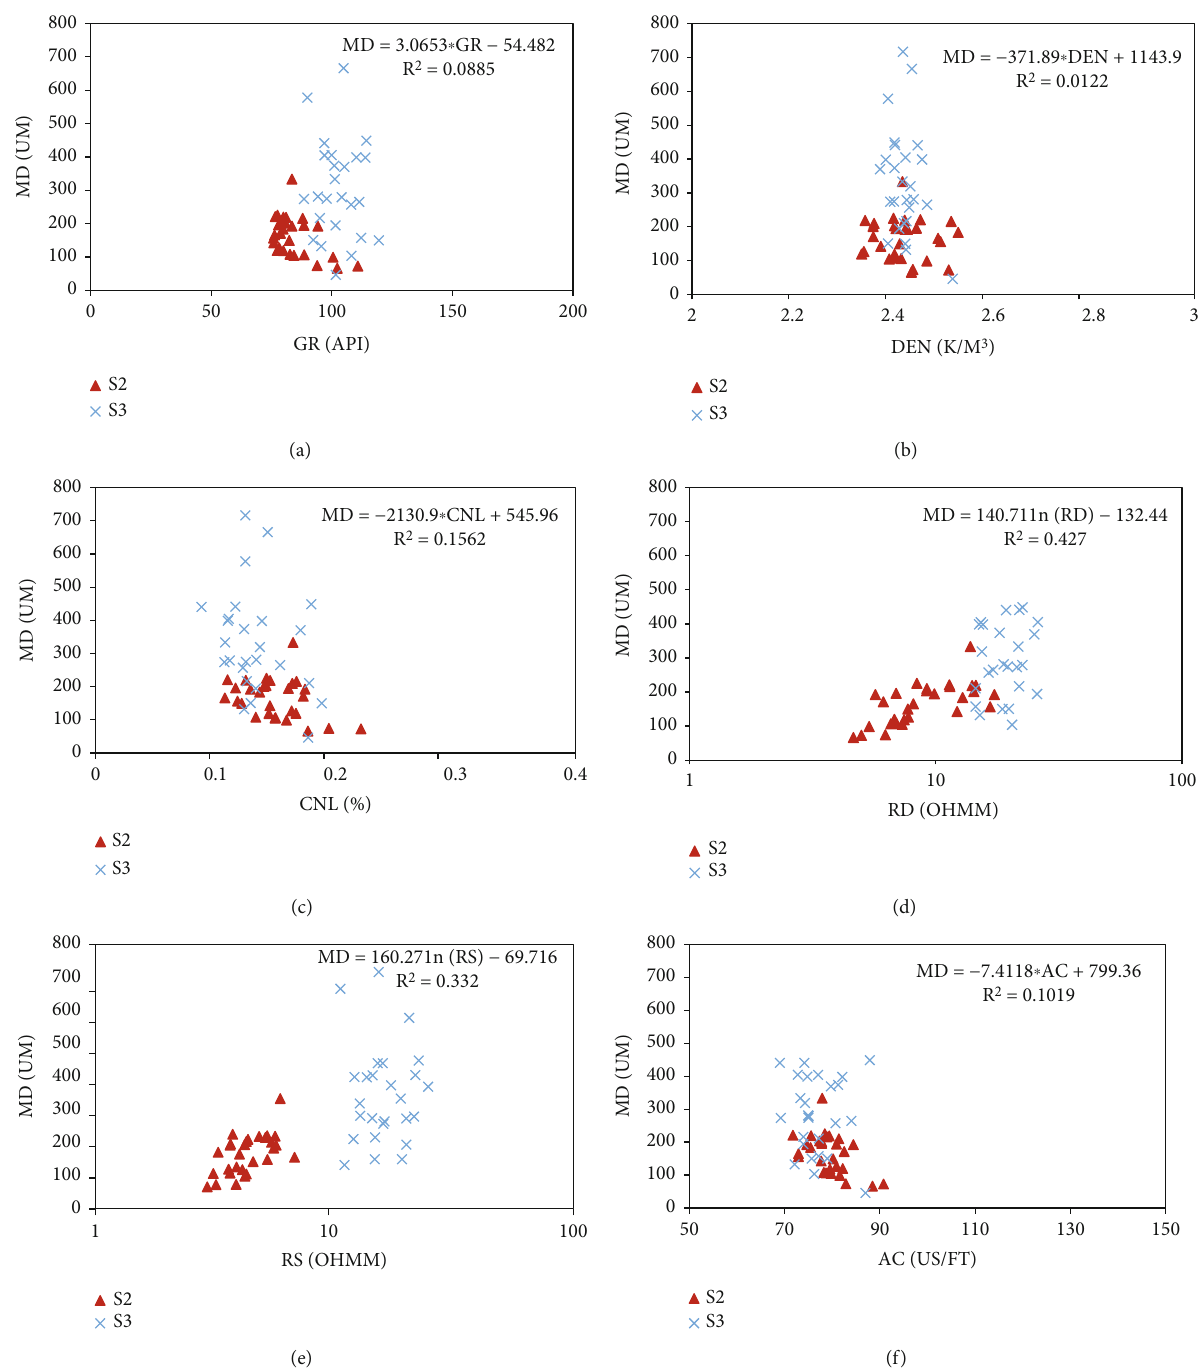
Figure 6: Intersection diagram of sensitive parameters and median granularity in S